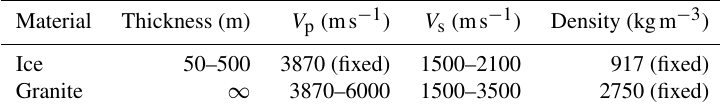
Table 1. Parameter ranges and fixed parameters for grid search to invert the dispersion curves in Fig. 5 for ice thickness. Poisson’s ratios of ice and granite were varied between 0.2 and 0.5. Poisson’s ratio, ice thickness, and P-wave velocity V p were coupled to the S-wave velocity V s